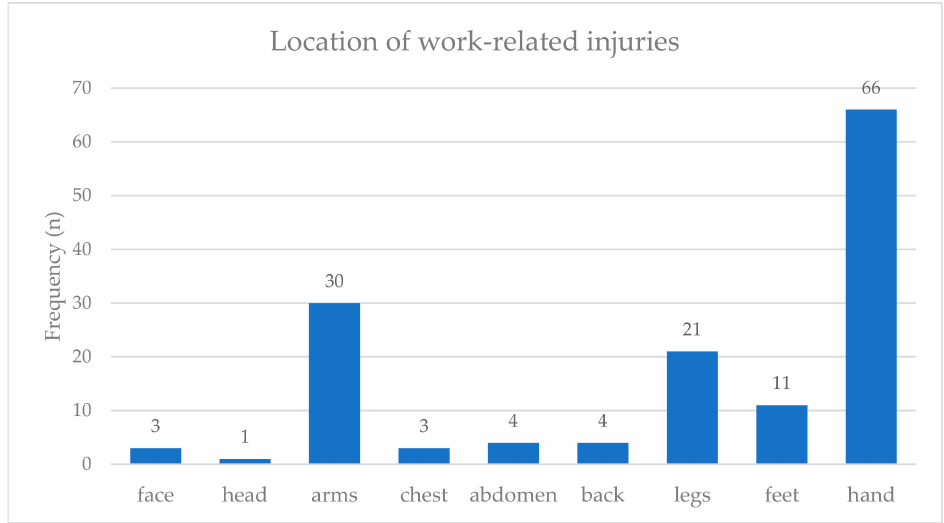
Figure 2. Distribution of the location of work-related injuries for all e-waste workers and bystanders at the scrap yard ( n = 178).